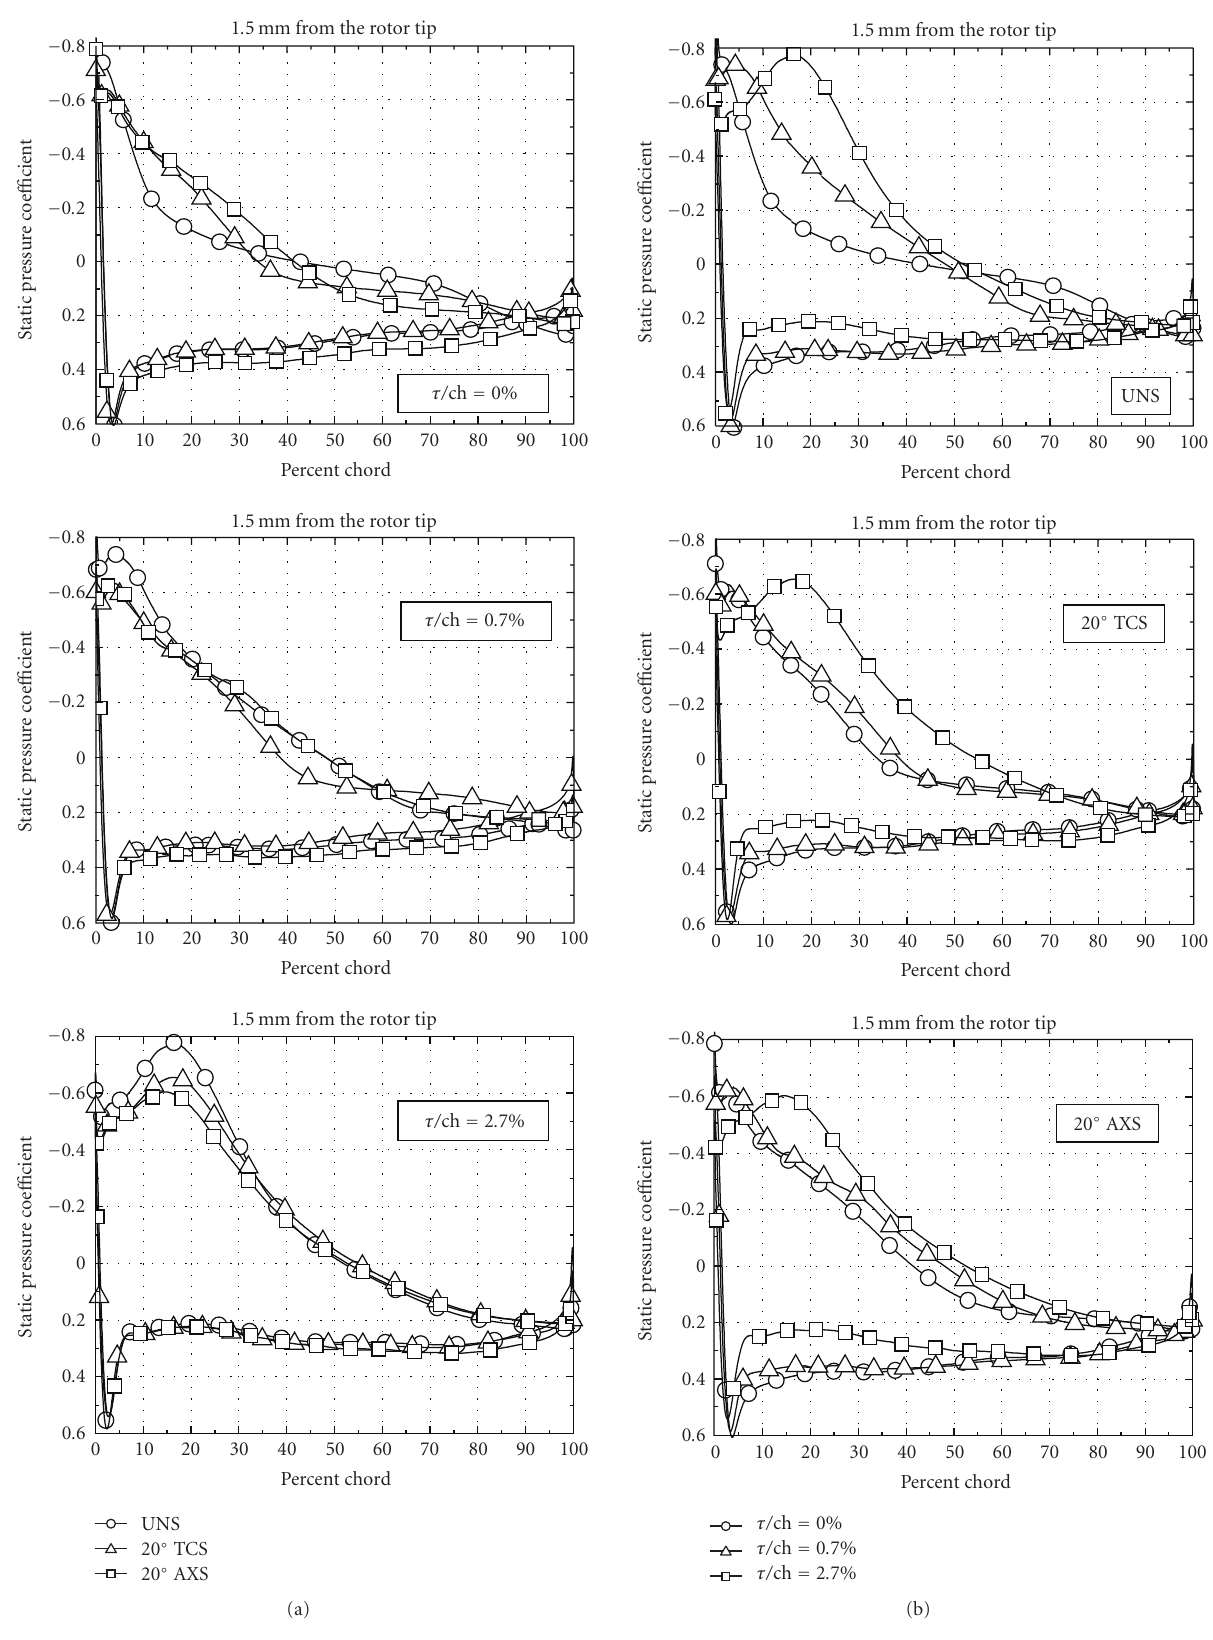
Figure 1: Static pressure distribution on the blade at S 1 , φ =